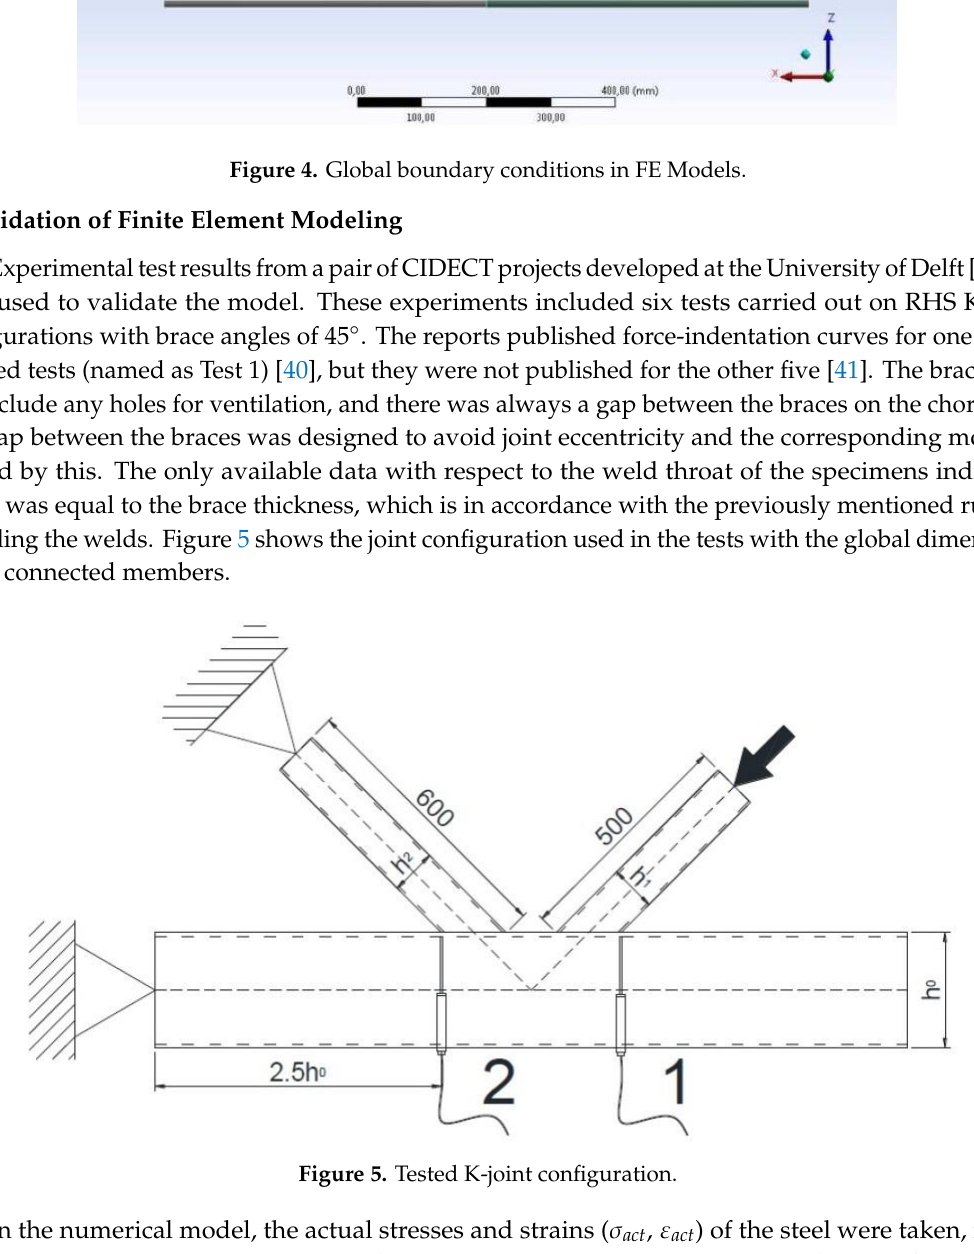
Figure 4. Global boundary conditions in FE Models.